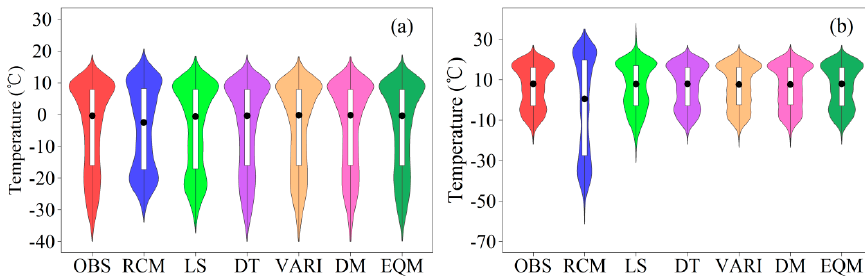
Figure 6. Violin plots showing the frequency distributions of the probability density function for the observed, RCM, and bias-corrected temperature in BYBLK ( a ) and BLT ( b ) meteorological stations. White bars represent 25th–75th quantile values, and black dots indicate the median.